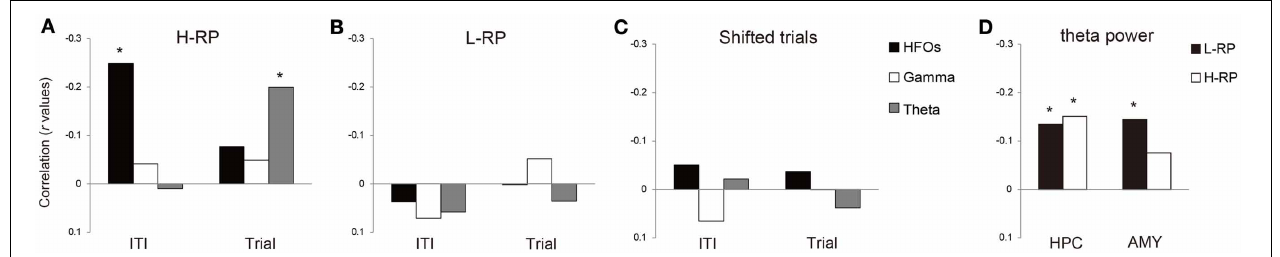
FIGURE 7 | Correlations between selection time and each of the three distinct bands of coherence (HFOs, gamma, and theta) during ITIs and trials. (A) H-RP condition. The ordinate indicates the correlation presented as r values. The asterisks mean significantly